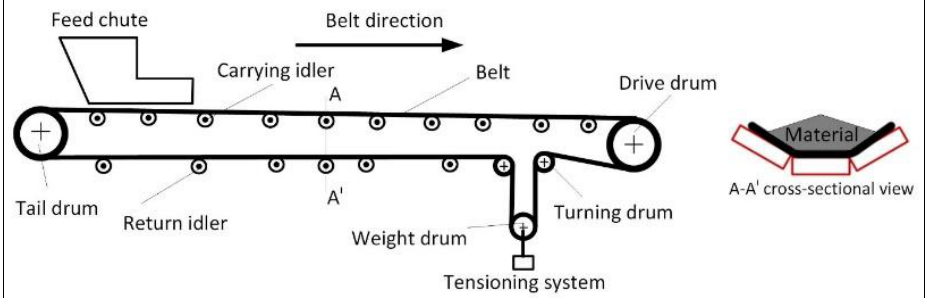
Figure 1: Schematic View of Belt